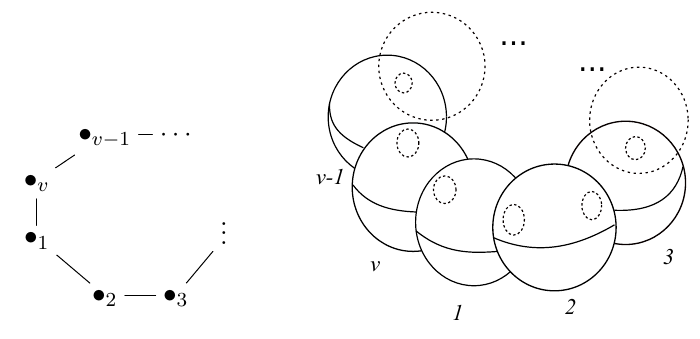
Figure 1 . Schematic topology of B L